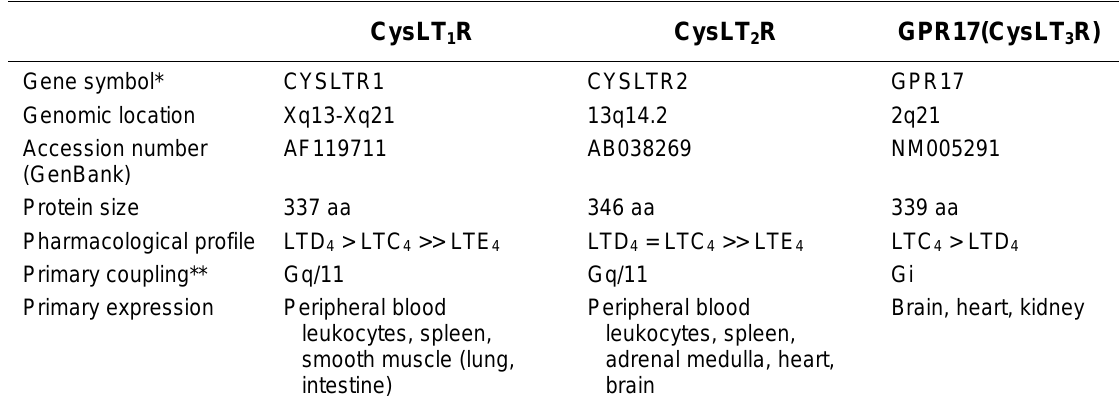
Schematic Characteristics of Cloned Human